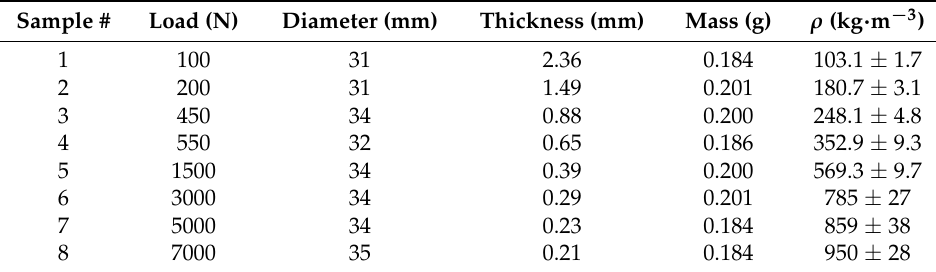
Table 1. Different tested samples, pressing load, and resulting density.